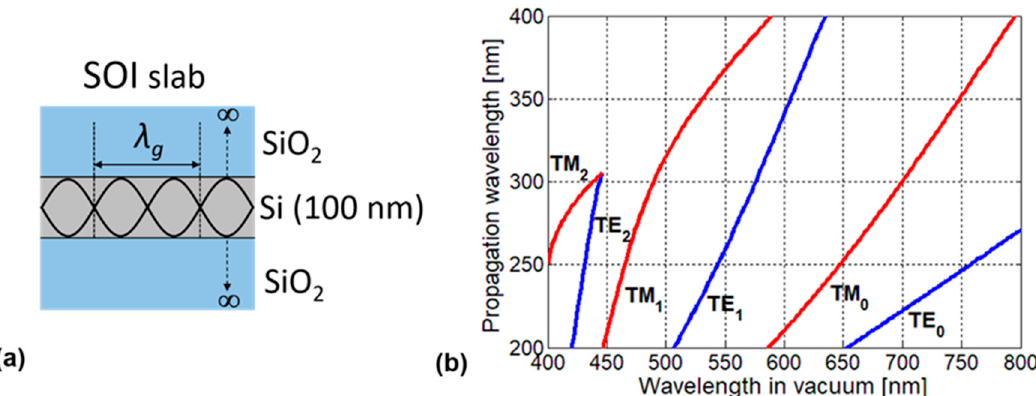
Figure 3. ( a ) The three-layered symmetrical slab waveguide consists of a 100-nm-thick Si core and SiO 2 claddings; ( b ) Propagation wavelengths of the waveguide modes in the SOI layer calculated by the dispersion relation vs. the free space wavelength.